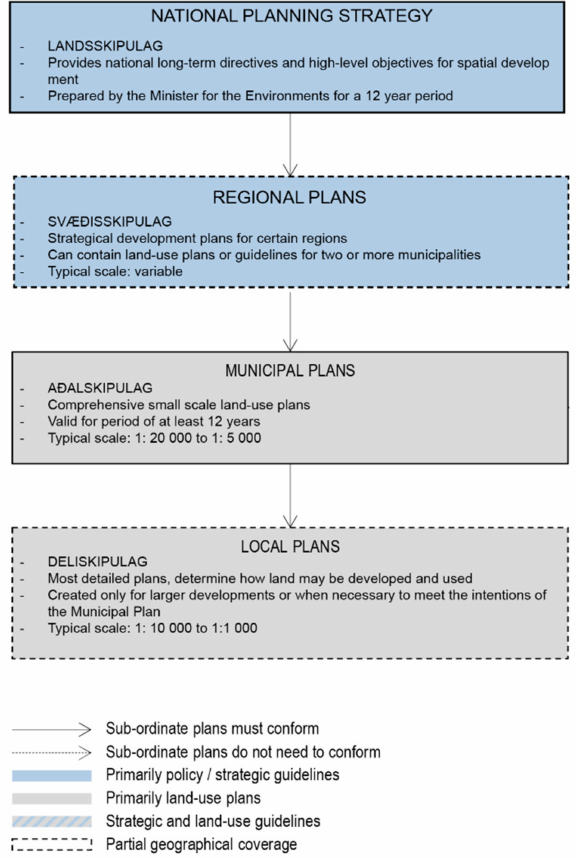
Figure 17. Organisation of spatial and land-use planning in Iceland. Source: authors based the OECD systematic